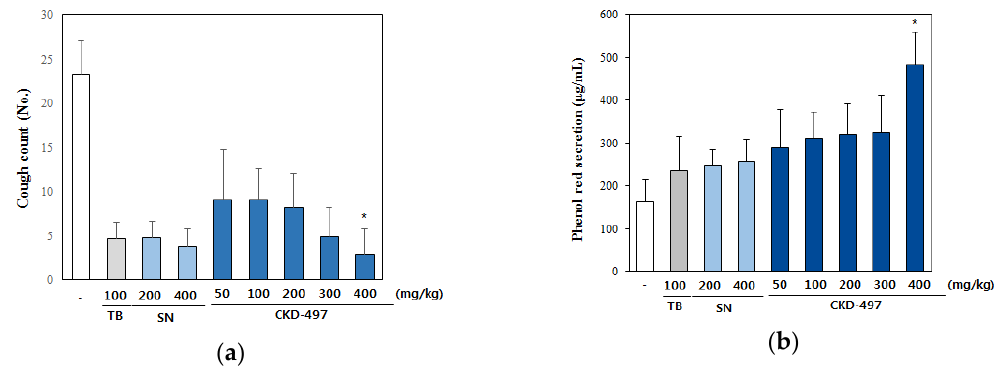
Figure 5. CKD-497 reduced the level of cough and increased expectoration of phlegm. ( a ) Spray of 5% citric acid induced cough after oral administration of CKD-497 in guinea pigs for 30 min. Then we counted the number of instances of coughing. ( b ) CKD-497 and positive controls were orally administered in mice for 30 min. Then, phenol red was injected in respiratory system for another 30 min. After euthanizing mice, respiratory system was extracted and washed. Optical density was measured with the liquid. Data are expressed as the mean ± SEM ( n = 8). * P < 0.01 compared with Synatura 200 mg/kg group.